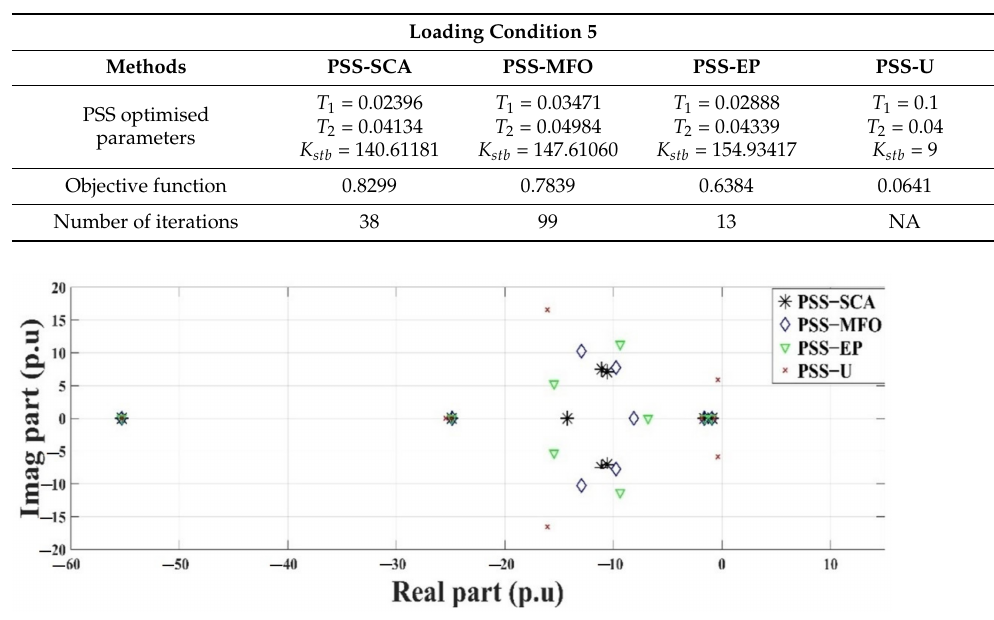
Table 11. Comparison of the PSS optimised parameters, eigenvalues, damping factor and damping ratio for loading condition 5 of the SMIB.